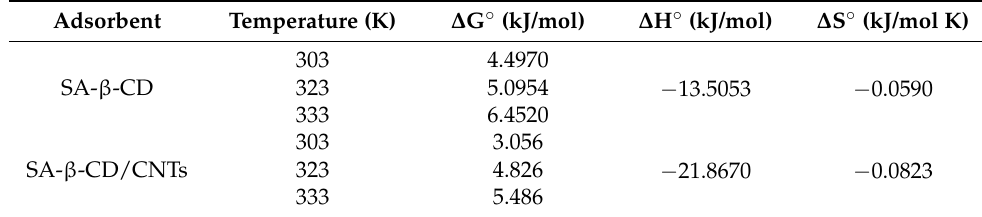
Table 3. Thermodynamic parameters.